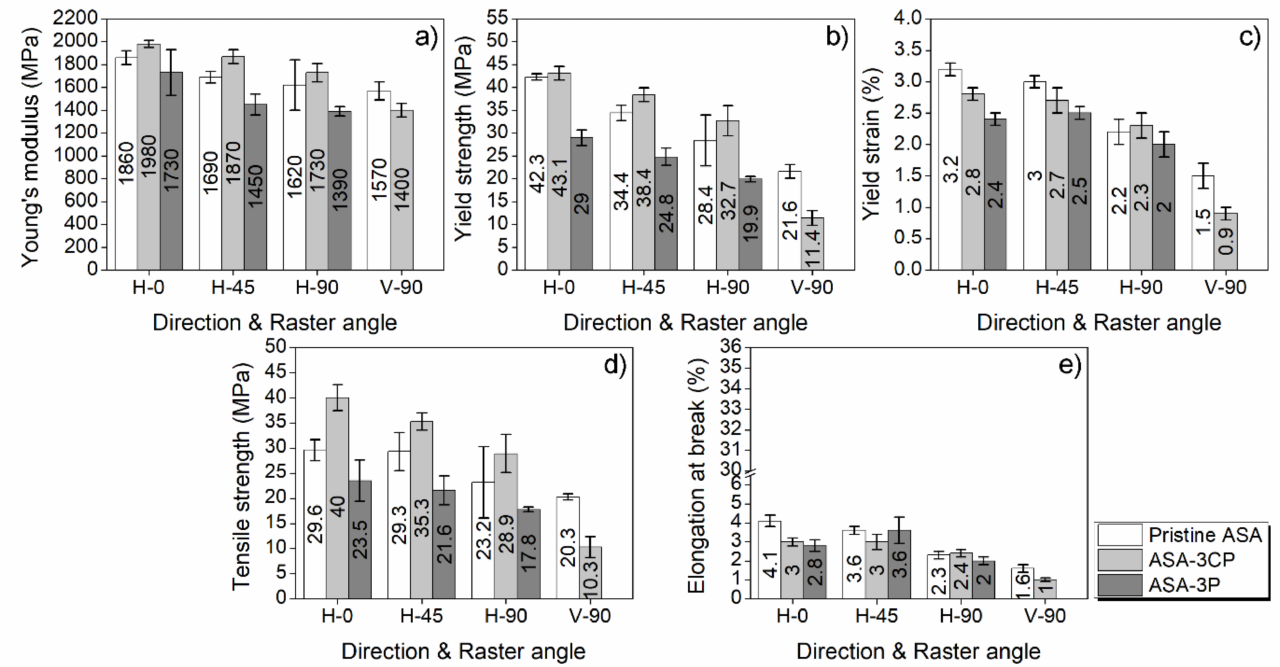
Figure 3. Mechanical properties of the FFF printed ASA (white bars), ASA-3CP (light grey bars), and ASA-3P (dark grey bars) with confidence intervals. ( a ) Young’s modulus; ( b ) yield strength; ( c ) yield strain; ( d ) Tensile strength, and ( e ) elongation at break. The composites were printed in horizontal and vertical orientation, using raster angles of 0, 45 and 90 ◦ for the first orientation (H-0, H-45, and H-90, respectively), and 90 ◦ for the second one